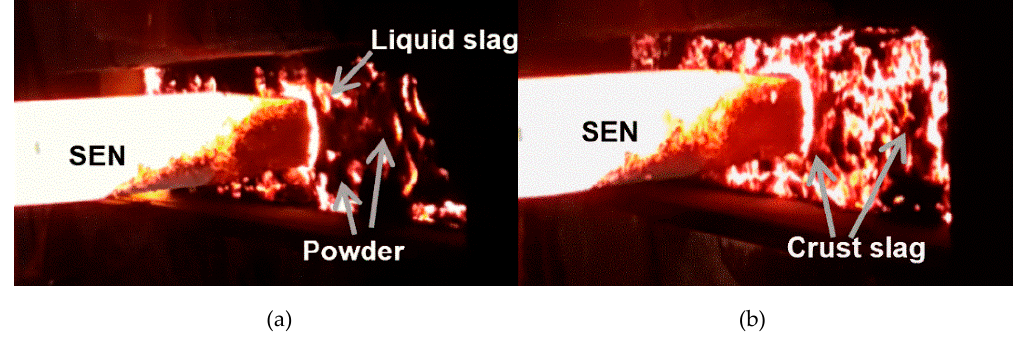
Figure 10. Condition of the mold slag in field test. ( a ) Early period; and, ( b ) ten minutes after the start of casting. Metals 2019 , 9 , x FOR PEER REVIEW